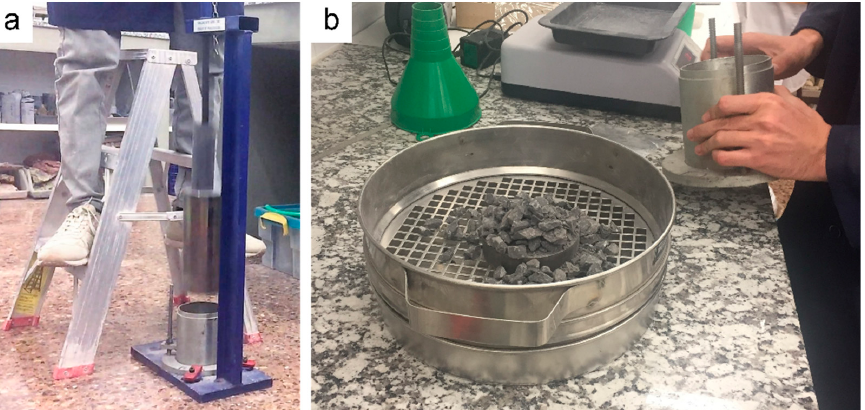
Figure 6. Crushing of the aggregate in the mortar ( a ) and determination of the percentage of material passing through the 11.2 mm sieve ( b ).